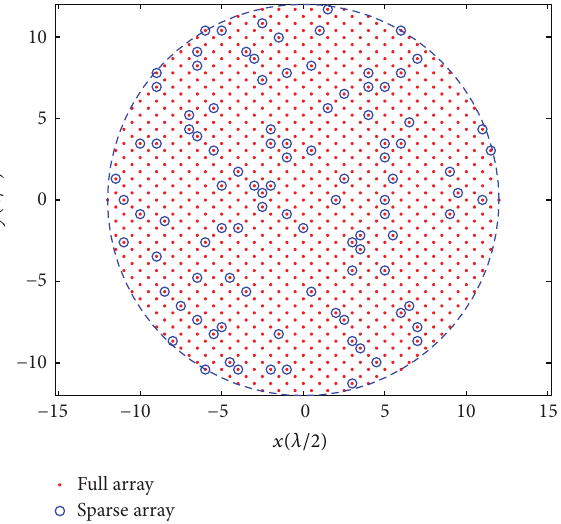
Figure 9: The distribution of the sparse array